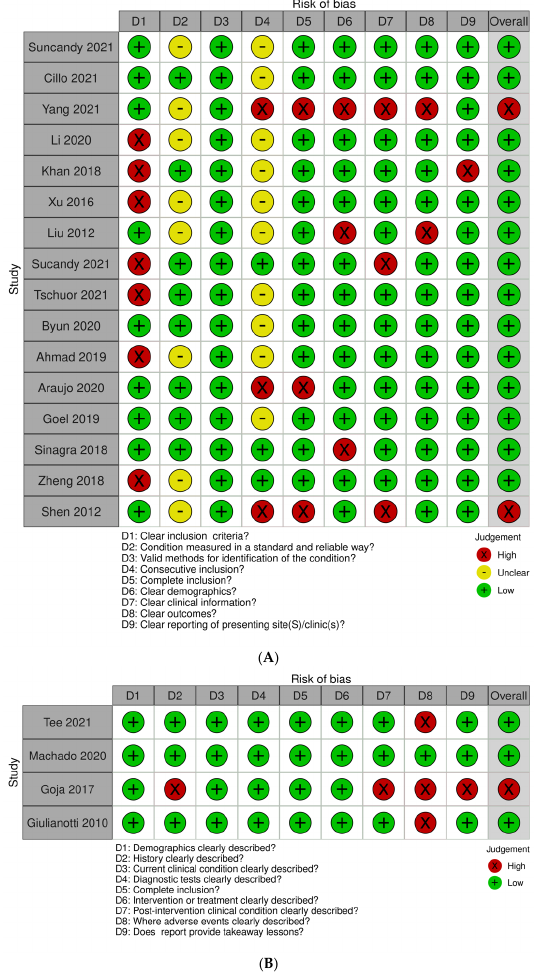
Figure 3. Traffic light plots of Joanna Briggs Institute critical appraisal for case series ( A ) and case reports ( B ) using the Robvis tool which provides copyright permission for publication of created figures